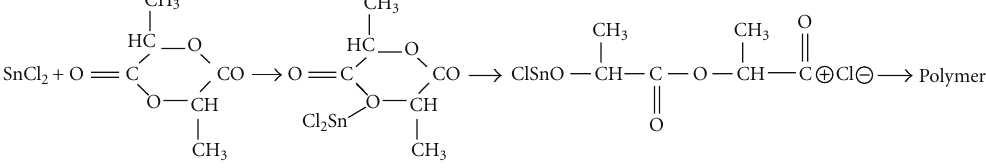
Scheme 1: Catalytical mechanism of SnCl 2 for PLA polymerization.